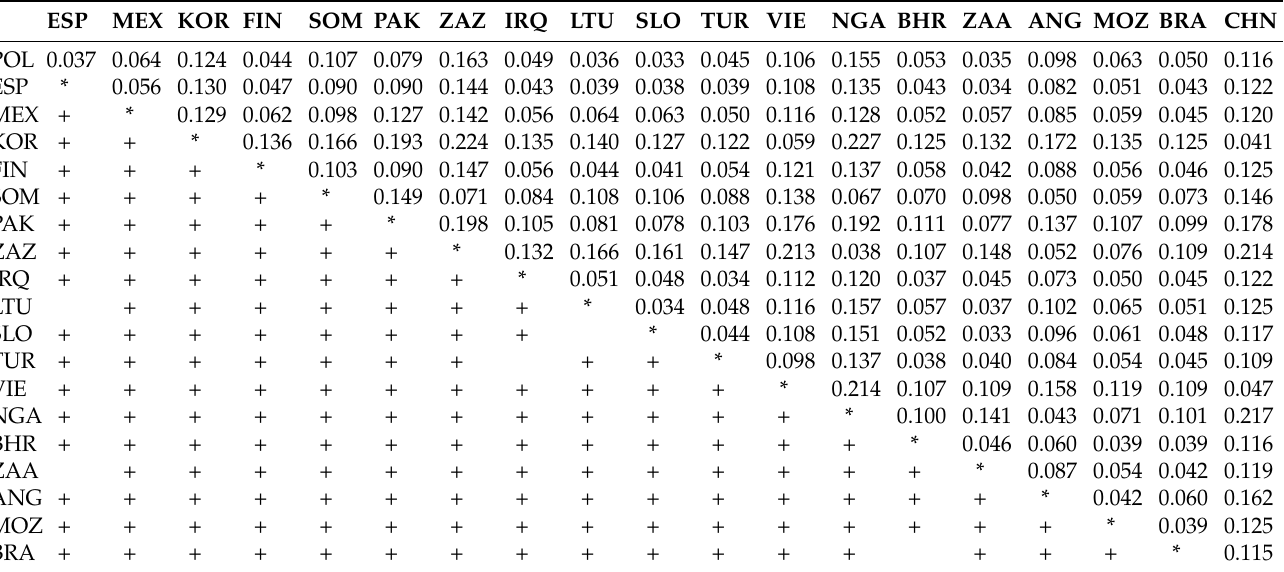
Table 2. Matrix of the pairwise FST genetic distances among the Polish population and 19 other reference populations.